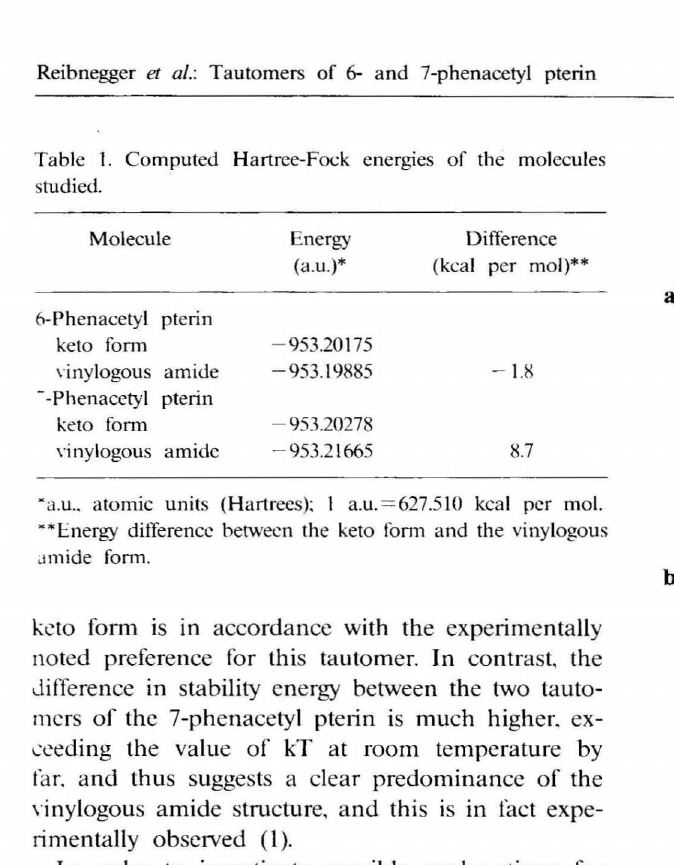
Table 1. Computed Hartree-Fock energies of the molecules studied.